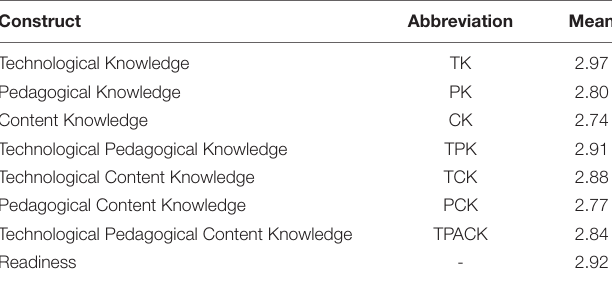
TABLE 2 | Technological Pedagogical Content Knowledge (TPACK) and technological